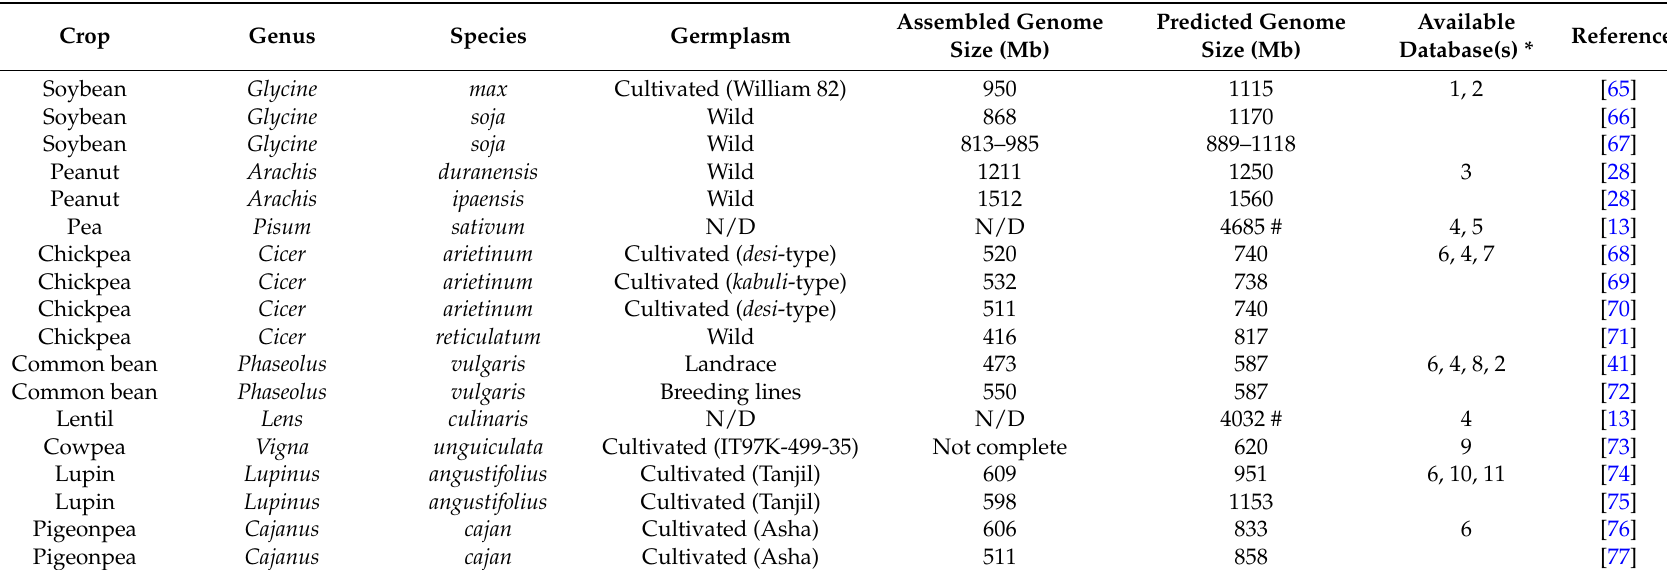
Table 1. De novo whole-genome sequencing results for various grain